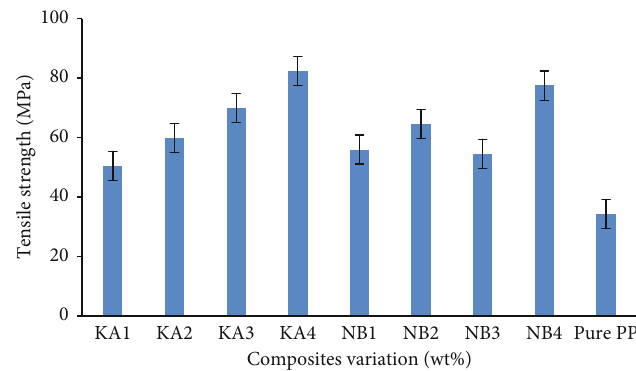
Figure 3: Comparison of tensile strength of reinforced composites and pure PP.